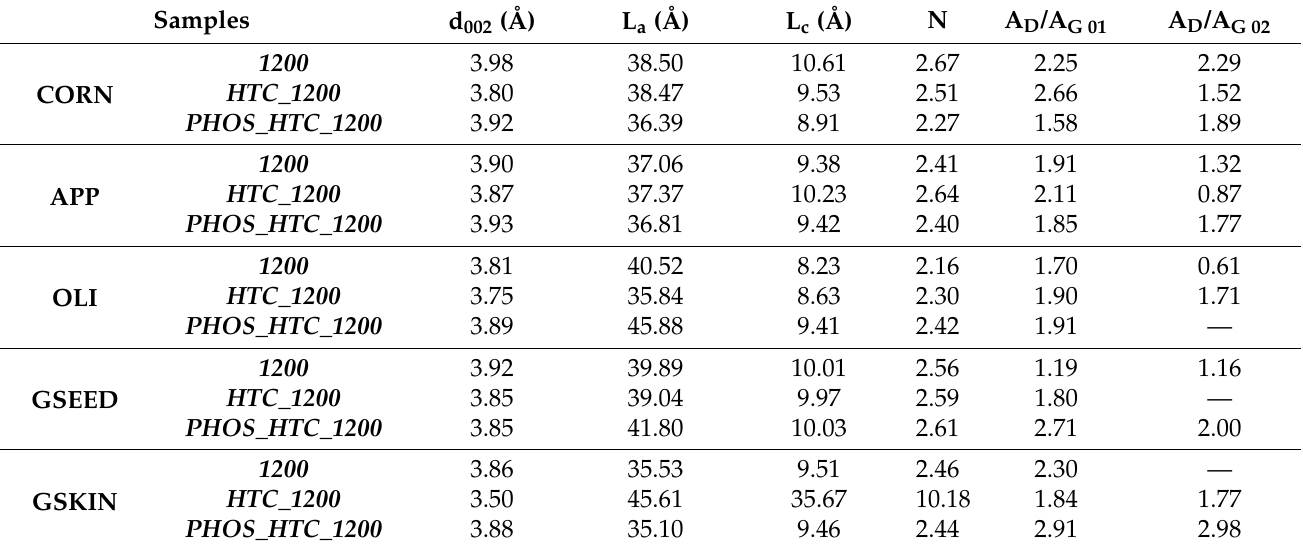
Table 3. Physical parameters of the samples calculated from XRD and Raman spectra.